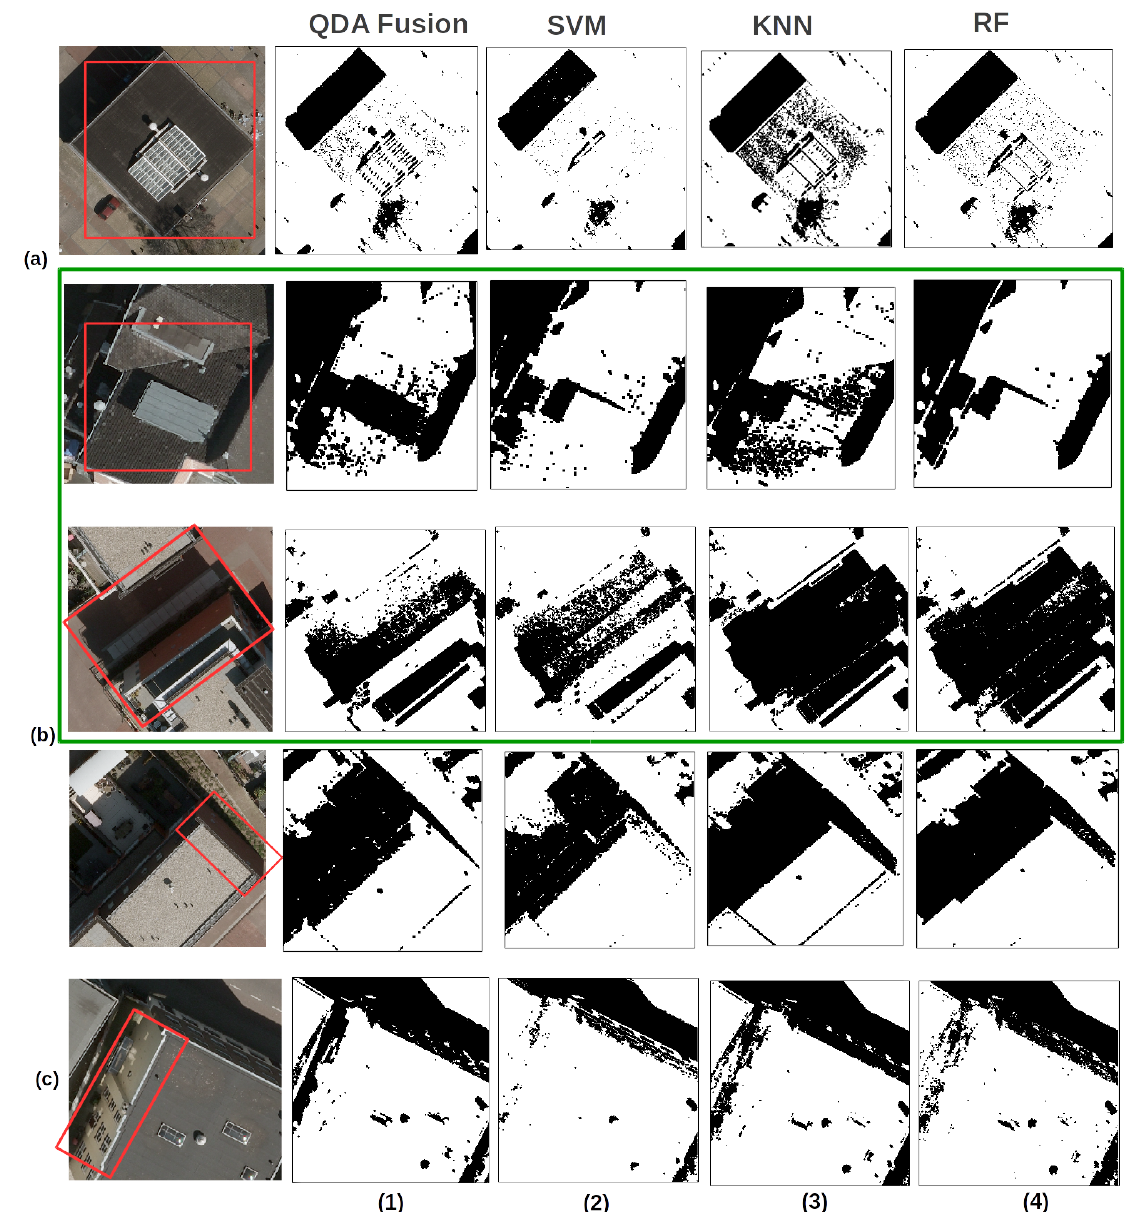
Figure 8. Results of four methods (1) QDA fusion; (2) SVM; (3) KNN; (4) RF for difficult cases: ( a ) two buildings with dark roofs; ( b ) two buildings with reddish bright facades and a bright reddish road. ( c ) a building with a very bright facade. The locations of these buildings are indicated in Figure 2. The results of property methods for the two cases in the green box are shown in Figure